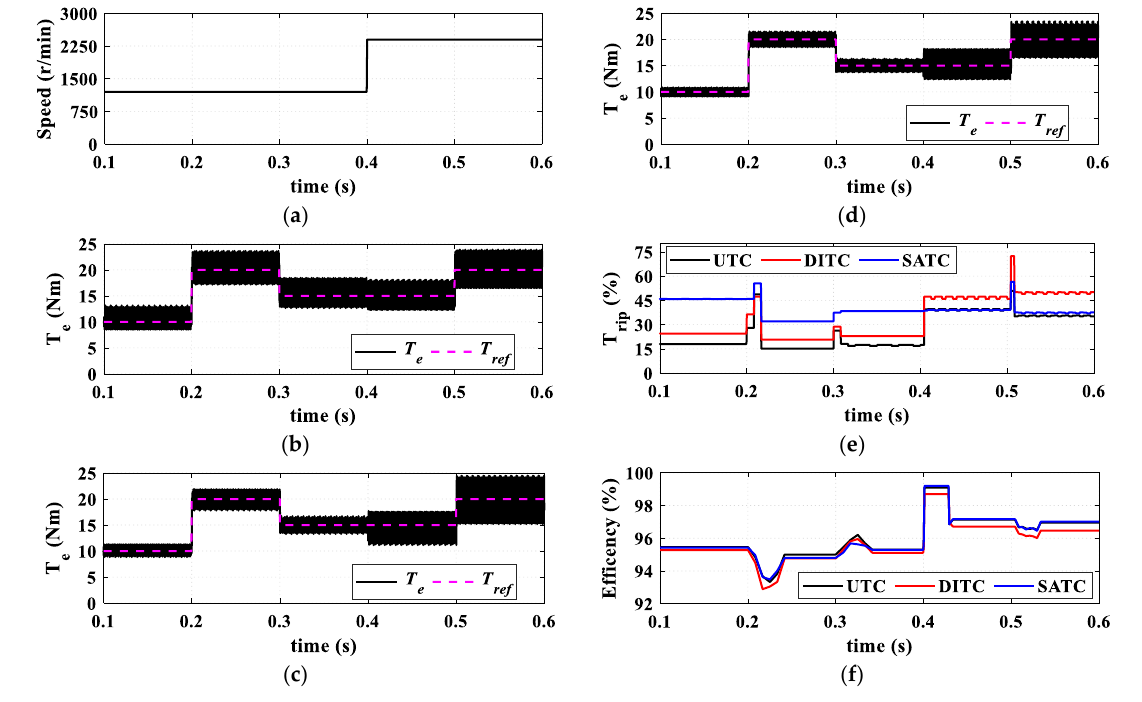
Figure 17. Comparative results under dynamic loading conditions. ( a ) Speed profile; ( b ) instanta- neous torque of SATC in [29]; ( c ) instantaneous torque of DITC in [28]; ( d ) instantaneous torque of UTC; ( e ) torque ripple; ( f ) efficiency.